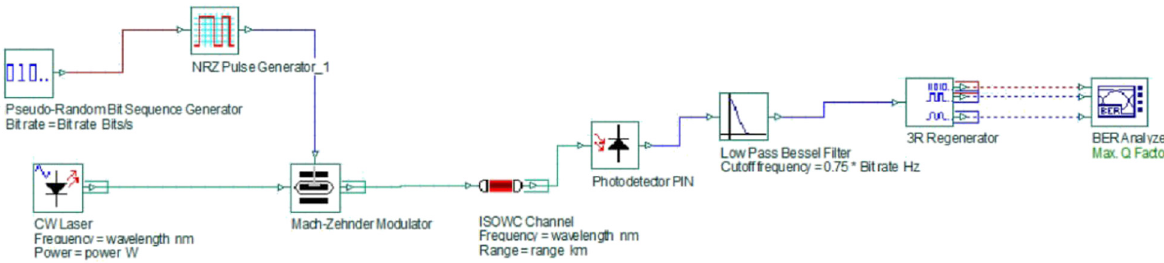
Figure 2: The OISN system was implemented by the OptiSystem.